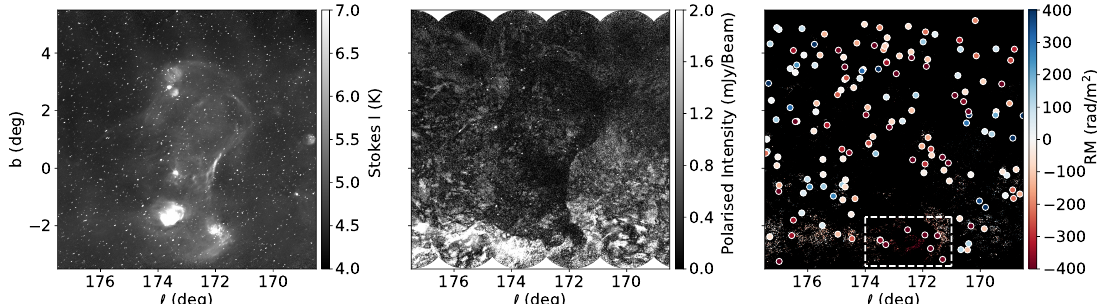
Figure 8. An HII region complex with an anomalous ratio of EG to XE RM values. Left : Stokes I total intensity map. Middle : Polarised intensity map, revealing the depolarisation in this region. Right : RM values of EG sources (dots) and the XE (background pixels.) The dashed line box highlights a grouping of strongly negative EG RM